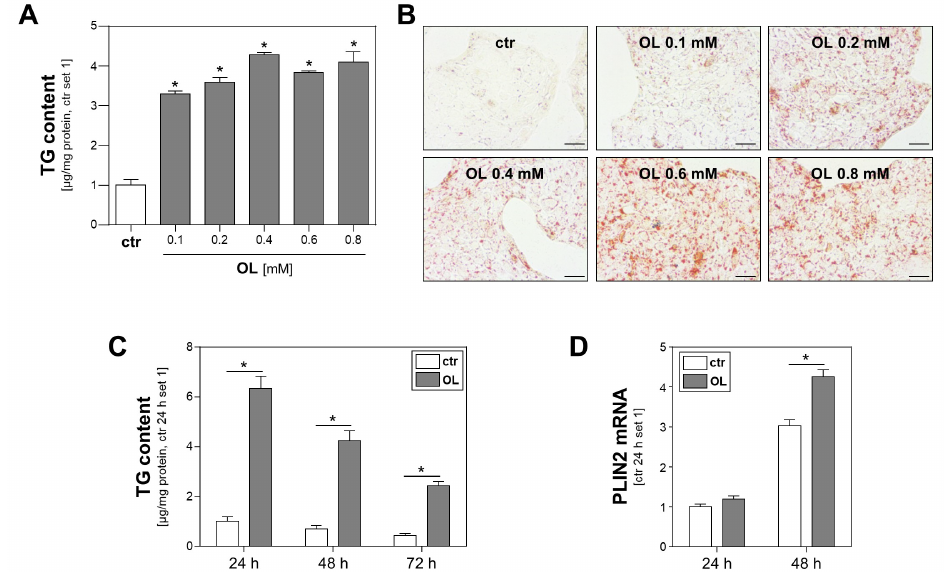
Figure 1. Effect of oleate treatment on lipid accumulation in Calu-3 cells. ( A , B ) Calu-3 cells were incubated with increasing oleate (OL) concentrations for 24 h. Cells treated with FFA-free BSA served as controls (ctr). ( A ) Triglyceride (TG) content normalized to cellular protein content (*: p < 0.05 compared to ctr). ( B ) Oil Red O staining; scale bars 50 µ m. ( C , D ) Calu-3 cells were incubated with 0.6 mM OL or FFA-free BSA (ctr) for different time intervals, as indicated. ( C ) Triglyceride (TG) content normalized to cellular protein content and ( D ) PLIN2 mRNA levels analyzed by quantitative RT-PCR (*: p < 0.05).